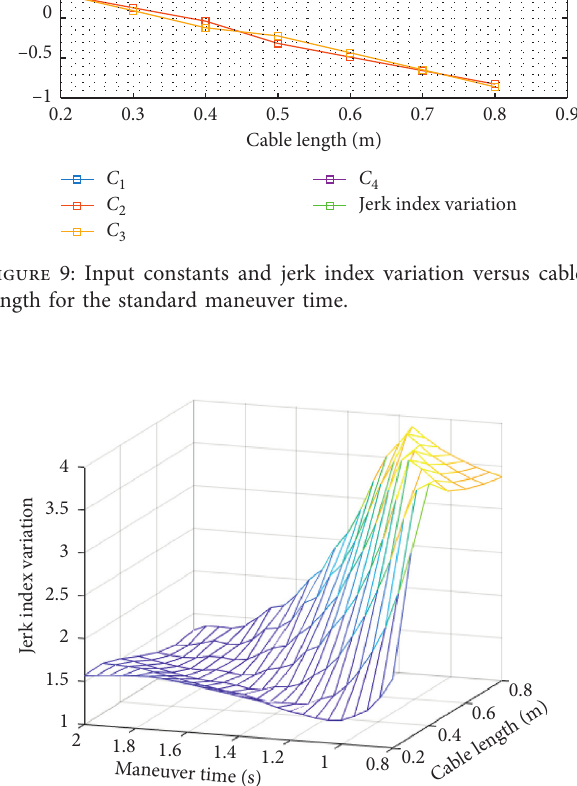
Figure 10: Jerk index variation over different maneuver times and cable